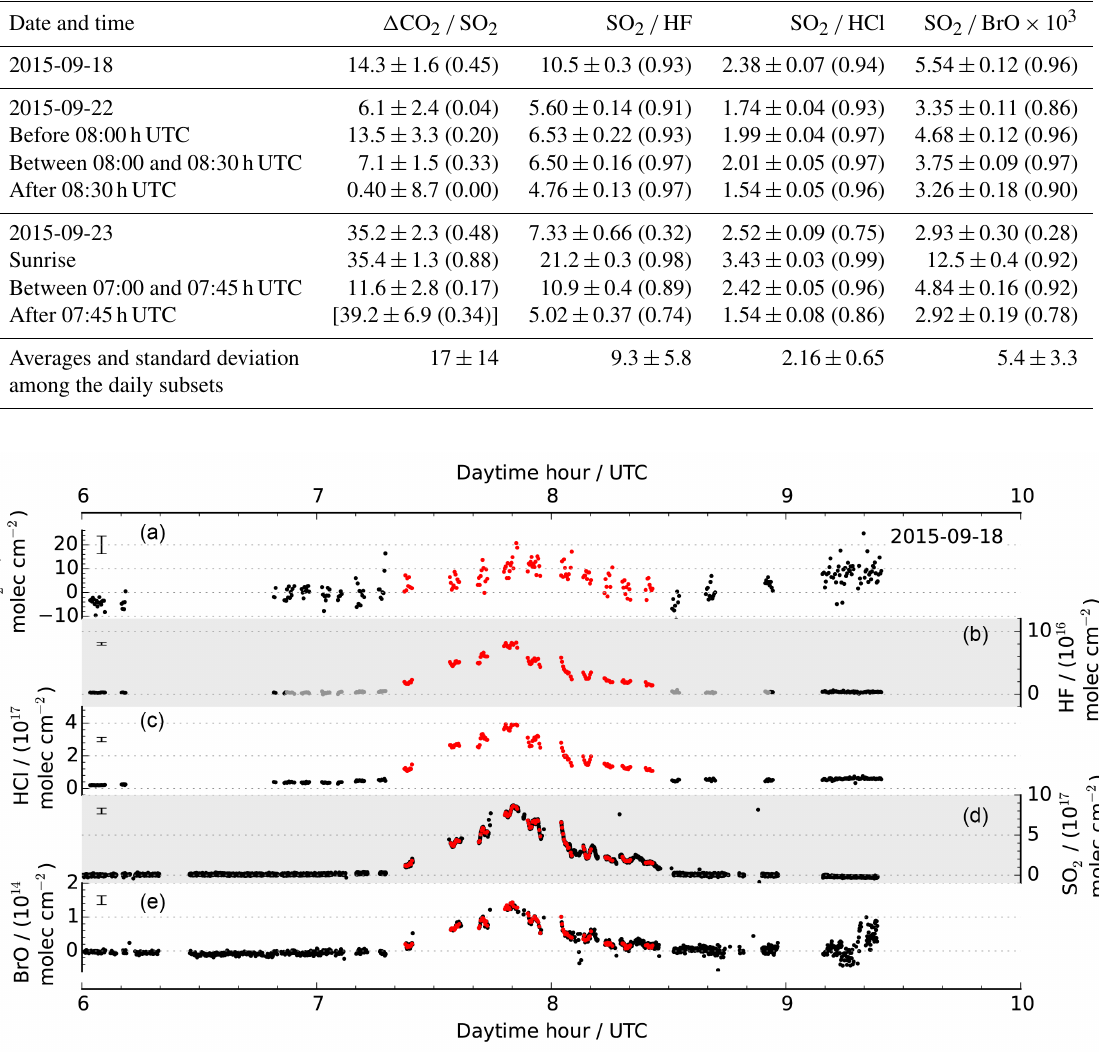
Figure 7. Time series of volcanic VCD enhancements in the plume of Mt. Etna observed on 18 September. (cid:49) CO 2 (first panel, left ordinate) correlates with enhancements in HF (second panel, right ordinate), HCl (third panel, left ordinate), SO 2 (fourth panel, right ordinate), and BrO (fifth subpanel, left ordinate). Grey symbols for HF indicate background measurements. Red closed symbols indicate intra-plume soundings used for further interpretation. For the UV-measured species SO 2 and BrO, we only consider those intra-plume soundings that occur within the integration time of a coincident FTS measurement. Therefore, some SO 2 and BrO measurements that are clearly intra-plume are not red colored. The precision estimated from the standard deviation of all background soundings is shown as an error bar in the upper left corner of each